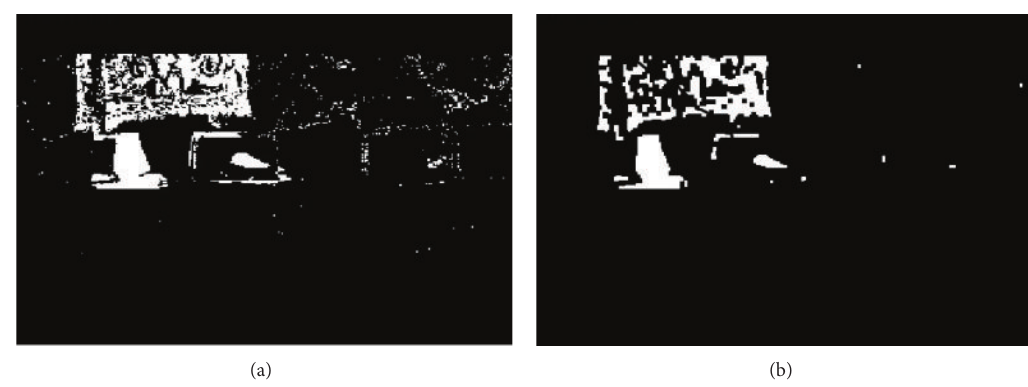
Figure 4: (a) The binarized image. (b) The same image after erosion dilation